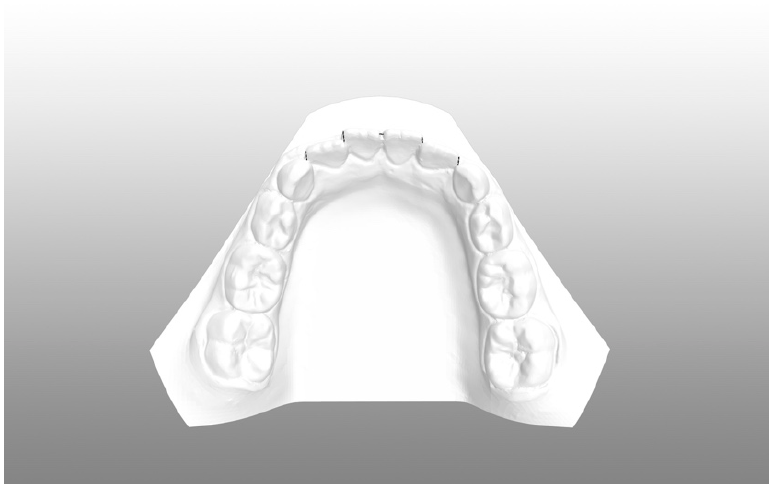
Figure 2. 3Shape Ortho Analyzer Tool used to measure the displacement of contact points on a digital 3D model.